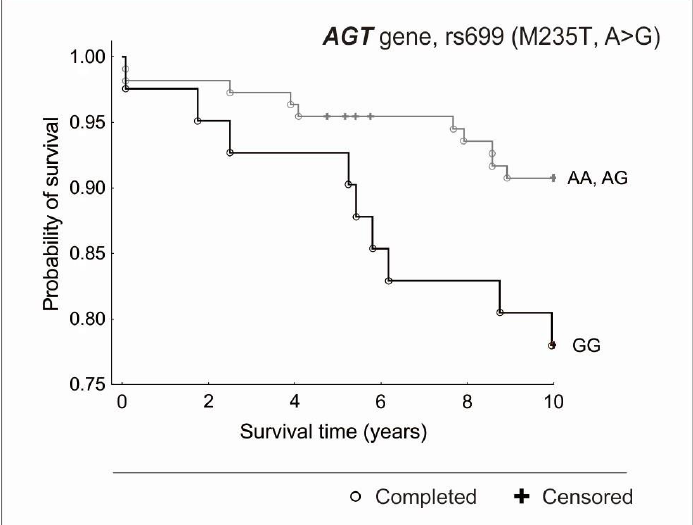
Figure 1. Kaplan-Meier survival curves for CAD patients by AGT gene, rs699 (M235T, A > G) in a 10-year observation ( p = 0.04 in the Cox proportional hazard model, p = 0.04 in the log-rank test). In the case of the ABCA1 gene, differences were also observed only in the 10-year follow-up. A significantly higher risk of death was found both in the additive model (genotypes) (HR = 1.91, 95% CI = 0.57–6.38, p = 0.04) and in the dominant model, where the risk of death was almost 2.5-times higher for the GG homozygotes compared to the allele A carriers (HR = 2.48, 95% CI = 1.14–5.39, p = 0.02) (Figure 2).